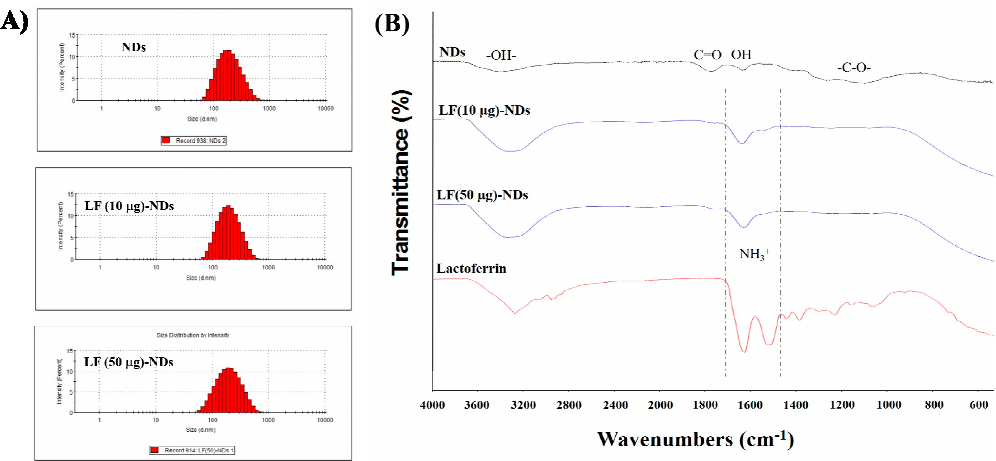
Figure 2. ( A ) Particle size and distribution of NDs, LF (10 µ g)-NDs and LF (50 µ g)-NDs measured by dynamic light scattering (DLS); ( B ) Attenuated total reflectance Fourier transform infrared (ATR-FTIR) spectra of NDs, LF (10 µ g)-NDs, LF (50 µ g)-NDs and Table 1. Surface elemental composition of NDs, LF (10 μ g)-NDs, and LF (50 μ g)-NDs. Elements